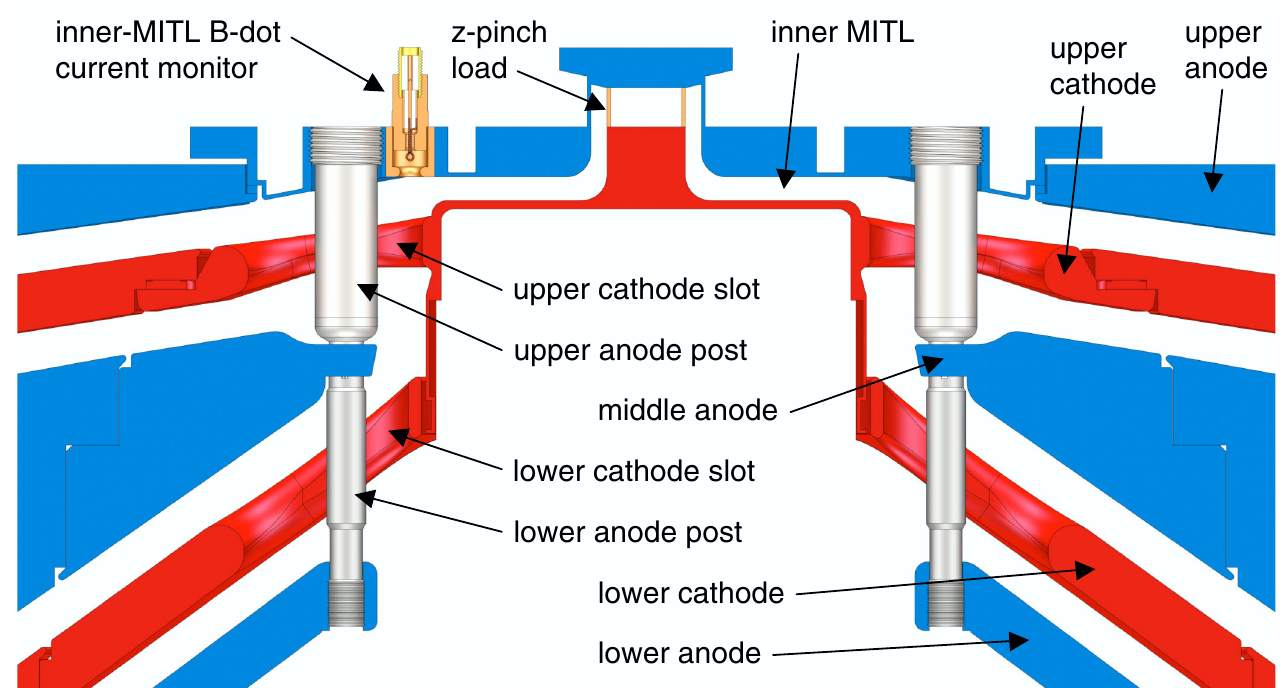
FIG. 3. (Color) Cross-sectional view of the double-post-hole convolute, inner MITL, and z -pinch